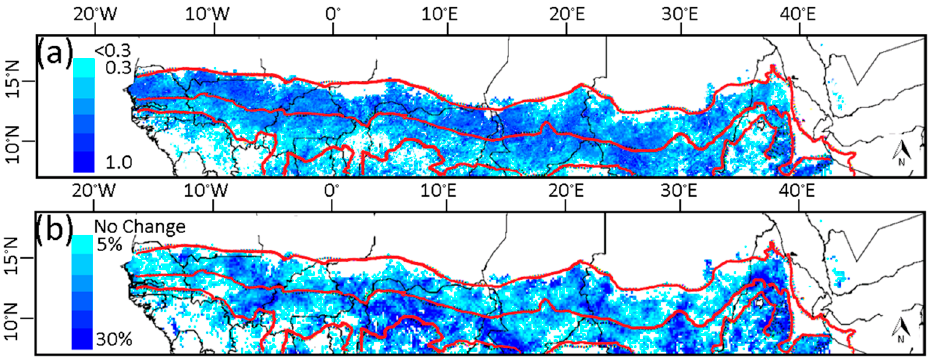
Figure 6. Spatial distributions of ( a ) the coefficients of determination (adjusted r 2 ) for the multiple regression of Σ NDVI on total growing season rainfall, its variance and its skewness. ( b ) The change in the percentage of variance explained by including the additional variables over the percentage variance of Σ NDVI and rainfall alone. The red lines from north to south are the 300 mm, 700 mm and 1100 mm rainfall isohyets.